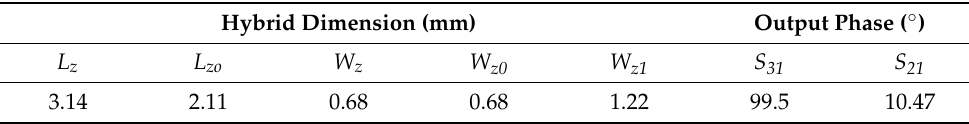
Figure 12. Hybrid performance: ( a ) S -parameter and ( b ) phase at the output ports. Table 1. Hybrid dimensions and output